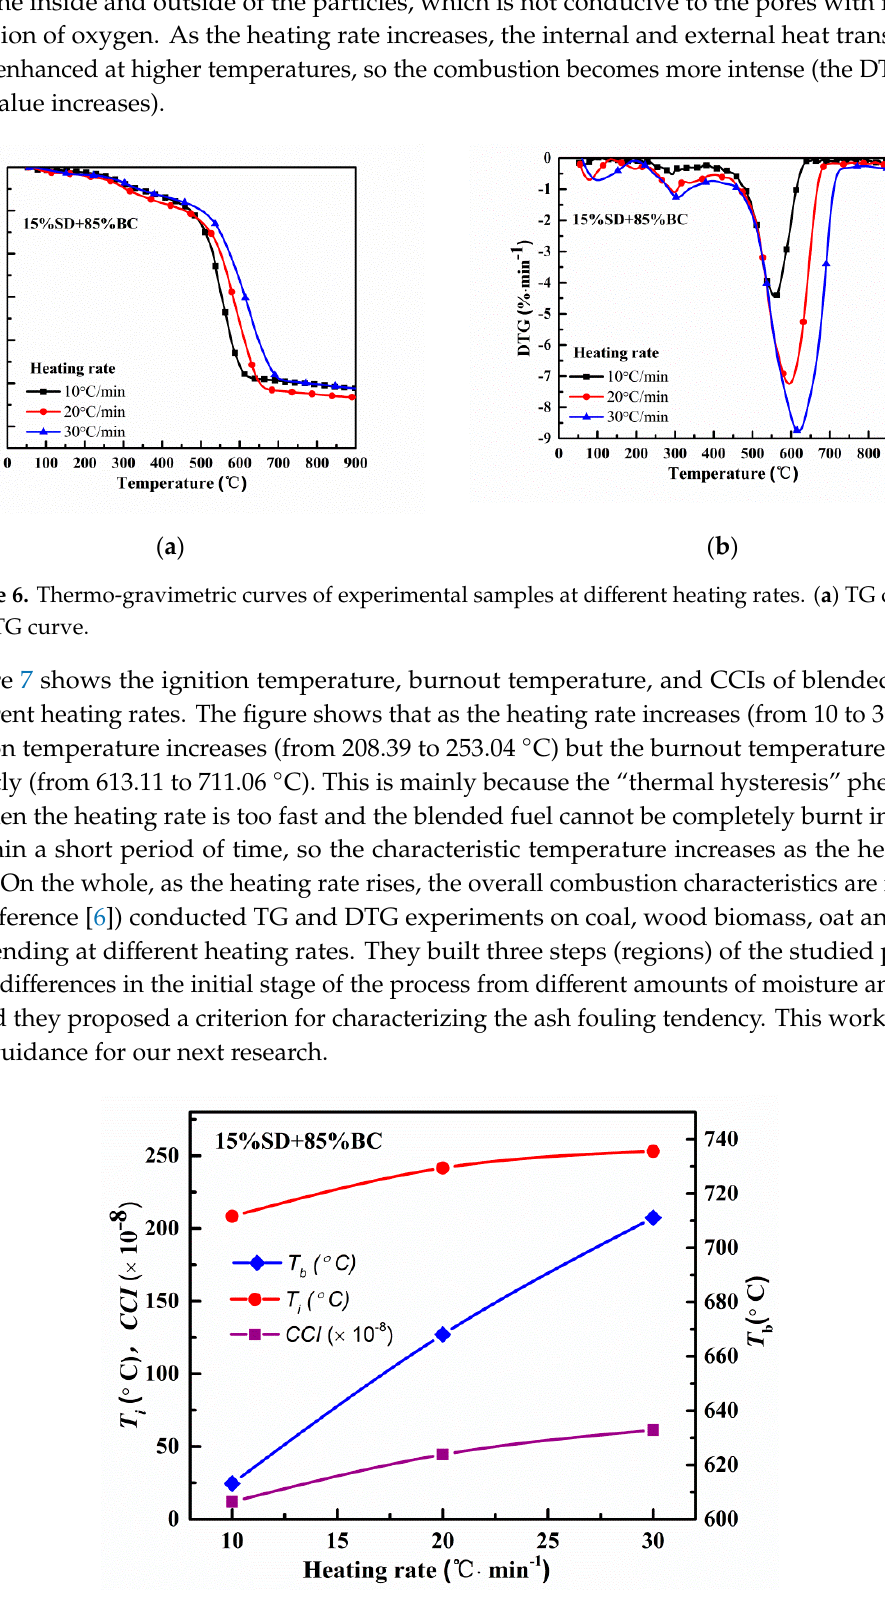
Figure 7. Ignition and burnout temperatures and CCI characteristics at different heating rates.